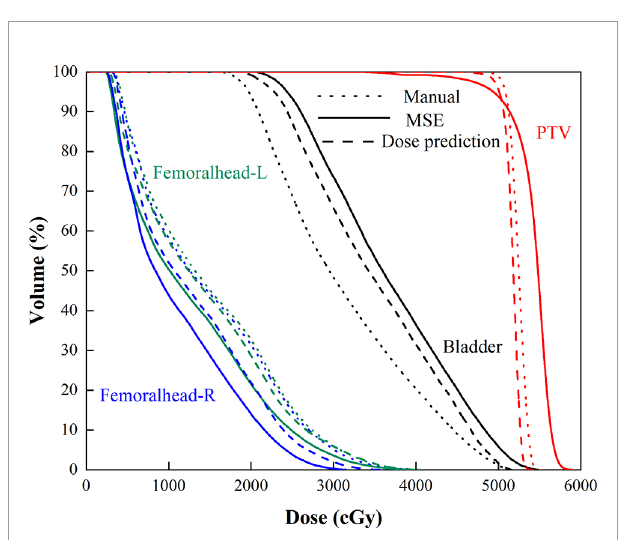
FIGURE 6 | Mean DVHs of the manual plan (dotted line), MSE optimization plan (solid line), and dose prediction based post-optimization plan (dashed